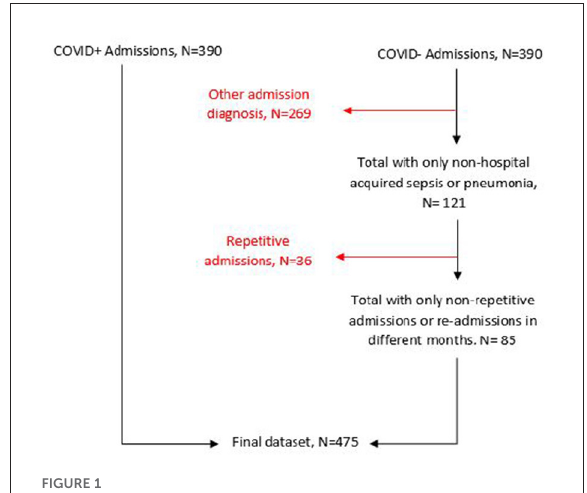
FIGURE1 Flow chart for dataset cleaning and